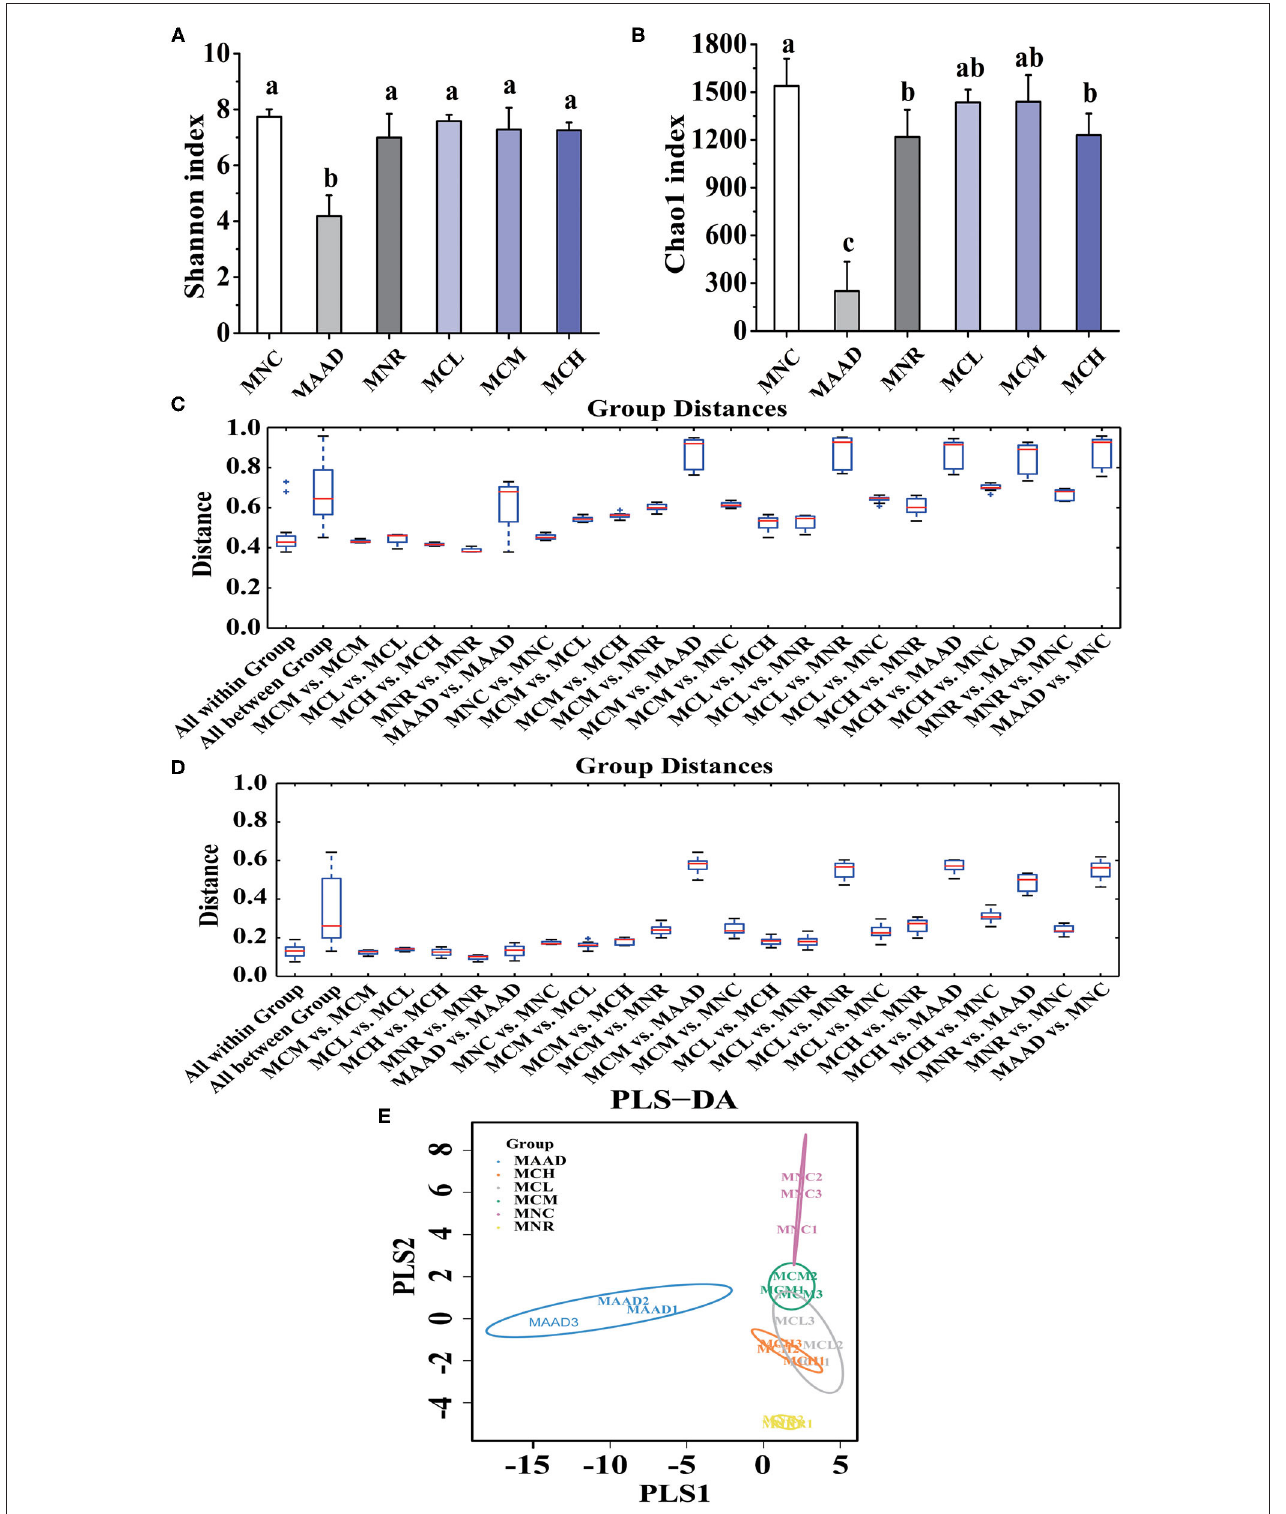
FIGURE 5 | α diversity analysis, (A,B) Shannon and Chao 1 indices, and β diversity analysis, (C,D) Unweighted and Weighted UniFrac-distance box-line graph, (E) PLS-DA analysis, of the gut microbiota. Values are shown as means ± standard deviation (SD). Different letters are significant differences ( p < 0.05).